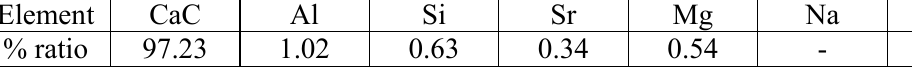
Fig. 4: XRD pattern of cockles shells powder showing predominating aragonite phase in the powder as evidenced from the main reflections. Table 2: Chemical analysis of cockles shell powder by XRF.